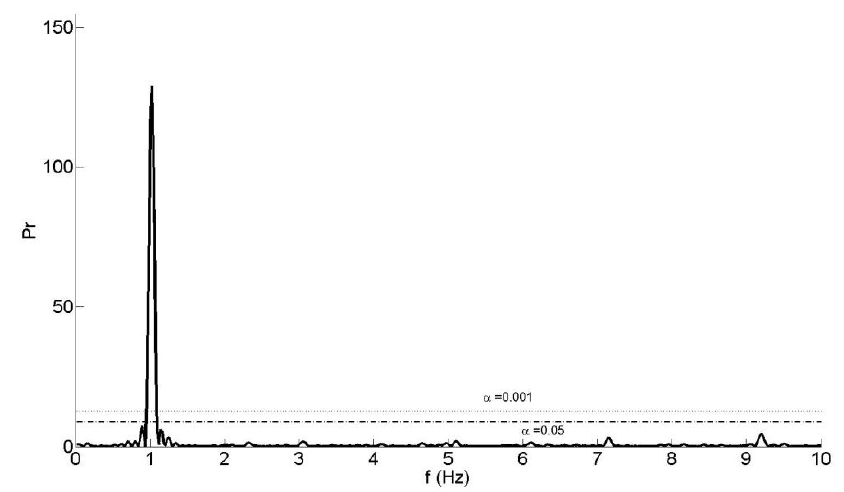
Figure 2. PSD of the depth time